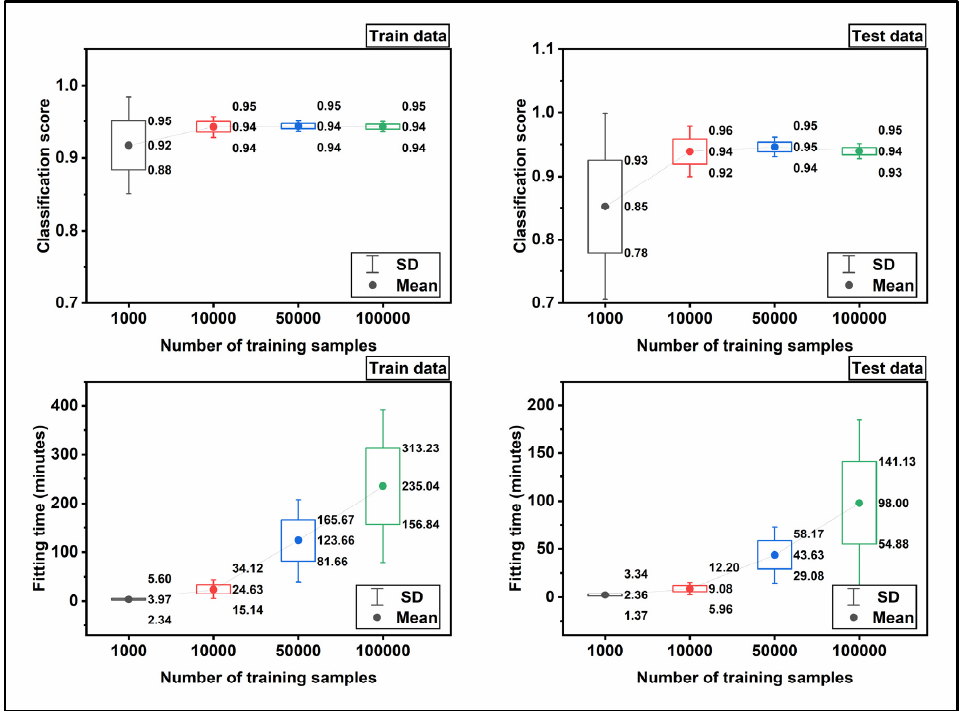
Figure 8. The plots demonstrate the results of the NN verification with make-moons and make-circles data set, which is the scikit-learn standard data set.